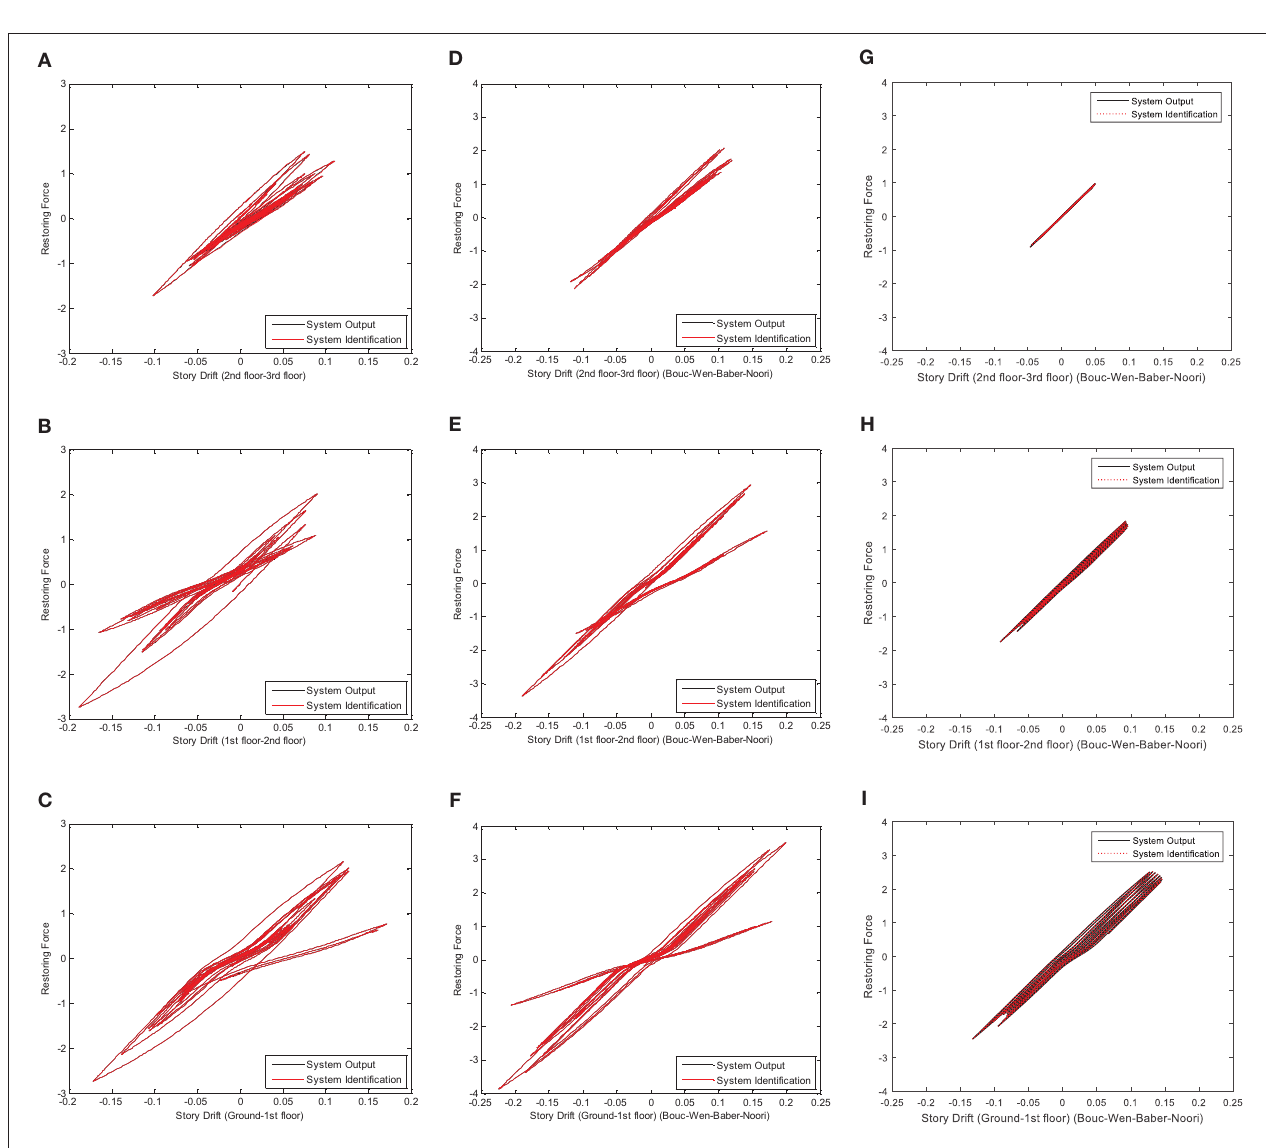
FIGURE 8 | System identification results (ElCentro) (A–C) IPV, (D–F) GA, (G–I) TMCMC.